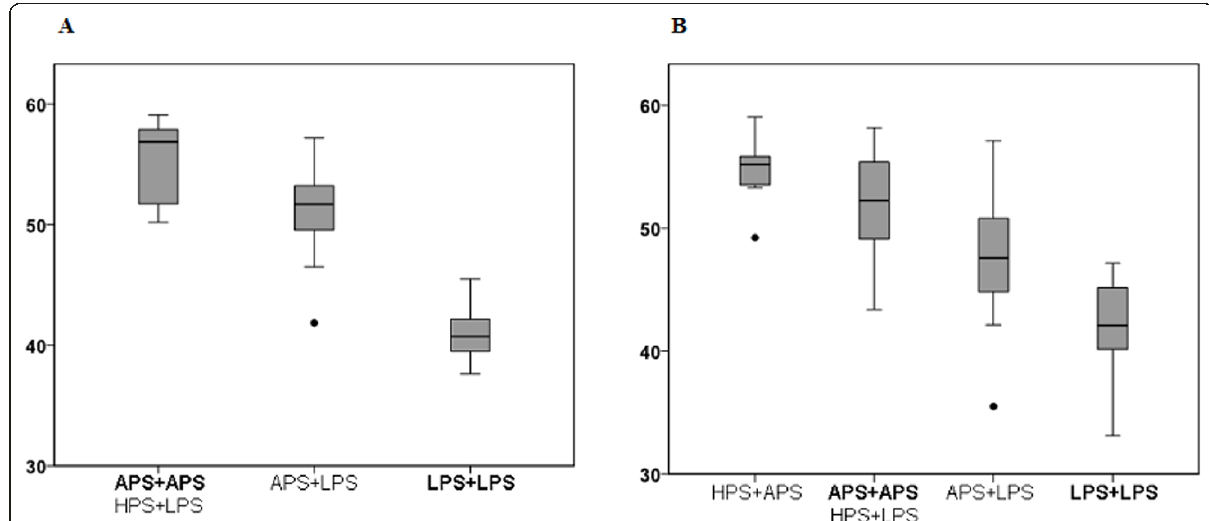
Figure 5 Mean S-COMT methylation levels with respect to the presumed COMT haplotype carrier status (A = twin cohort, B = adult controls) . In both cohorts, no individuals homozygous for the HPS haplotype were found. All other haplotype combinations were ranked within an imaginary scale corresponding to the proposed phenotypical differences (high > average > low pain sensitive, according to [Nackley et al.,